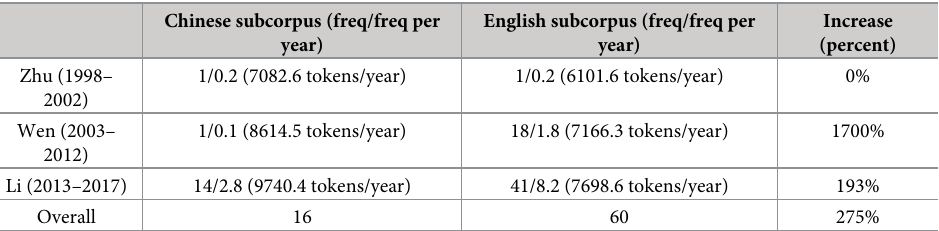
Table 4. Items relating to glob * in both subcorpora and across the